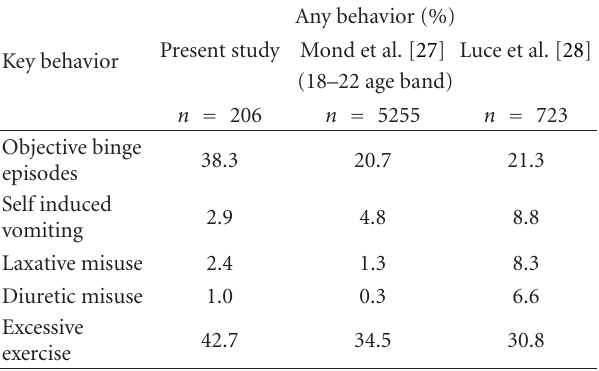
Table 3: Proportion of women engaging in any occurrence of key eating and compensatory